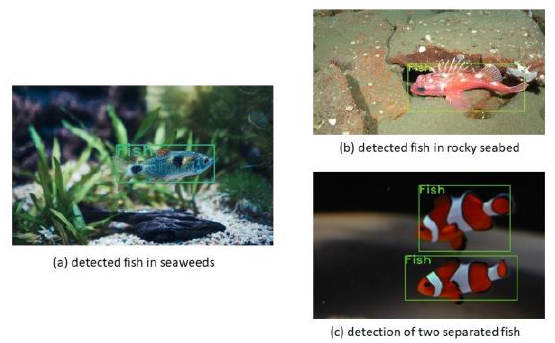
Figure 9 . Detection results in different environments: (a) detected fish in seaweeds, (b) detected fish in rocky seabed, (c) detection of two separated.